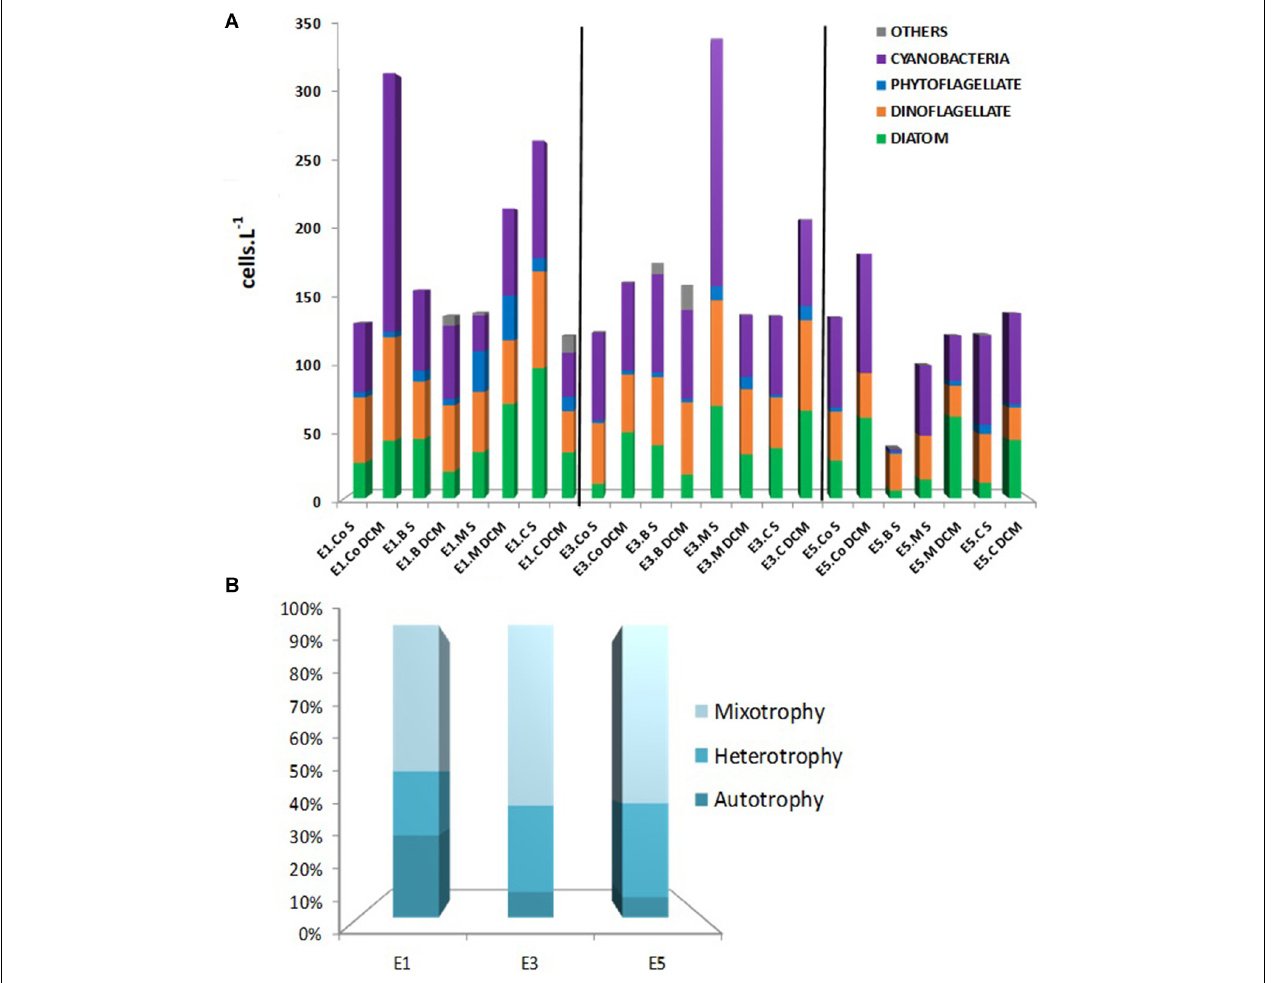
FIGURE 3 | (A) Group densities (cells.L − 1 ) of microphytoplankton in E1, E3, and E5—in the control, border, midway and center stations, surface, and DCM. (B) Frequency (%) of autotrophy, mixotrophy, and heterotrophy of